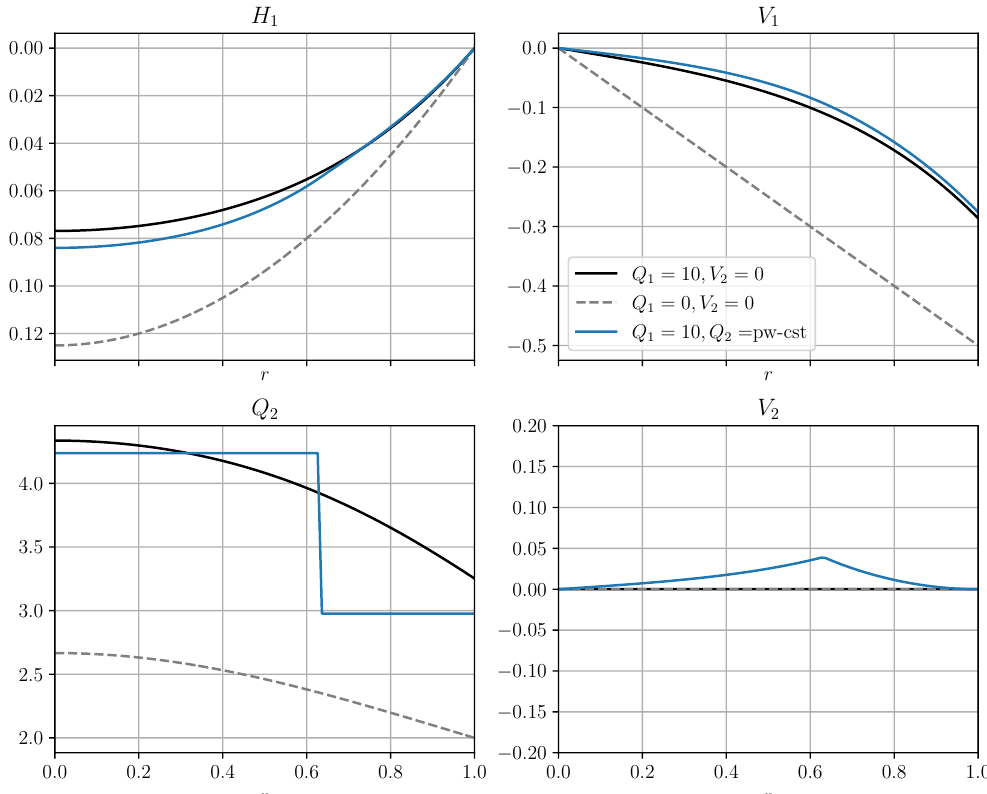
Figure 1. Basic vortex profile: nondimensional upper-layer thickness H 1 (upper left panel), lower-layer PV Q 2 (lower left panel) and upper and lower layer azimuthal velocity V 1 and V 2 (upper and lower right panels, respectively). The vortex parameters are Q 1 = 10, δ = 0.2, and the solution with a quiescent lower layer (black) is compared to the solution with a piecewise-constant lower-layer PV (blue). The analytical solution for Q 1 = 0, V 2 = 0 is plotted as a grey dashed line for